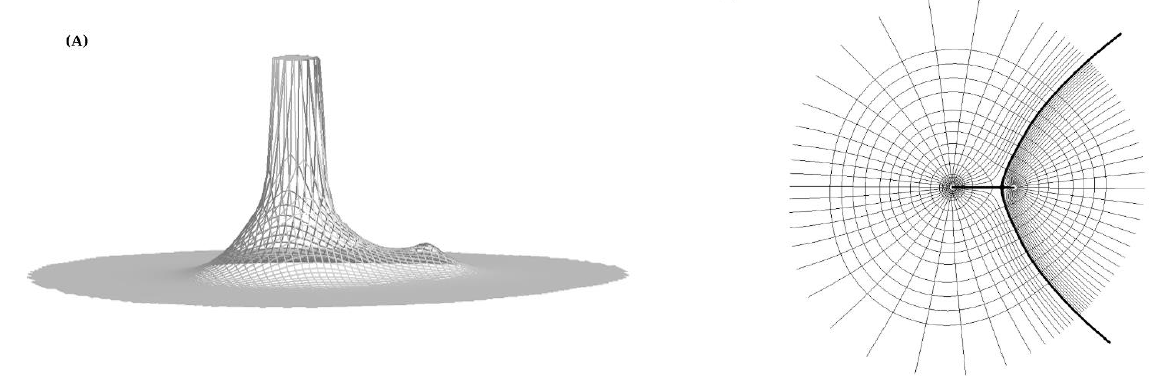
Figure 2. The relief map of electron density distribution in the hydroxyl group ( A ). The two-dimensional scheme of the division of the physical space on monoatomic subspaces occupied by the atoms of the hydroxyl group ( B ).